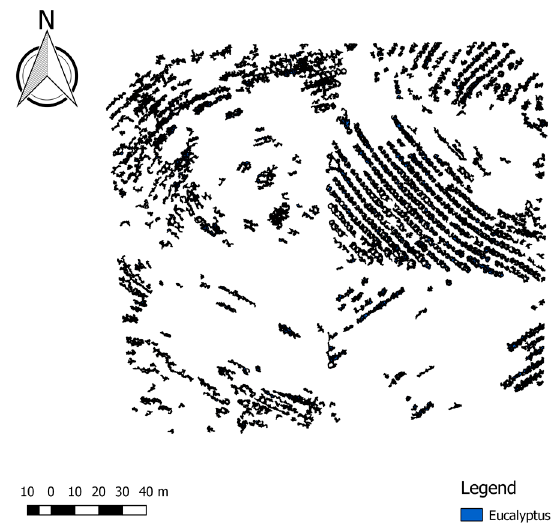
Figure 11. Eucalyptus crop plugin result.